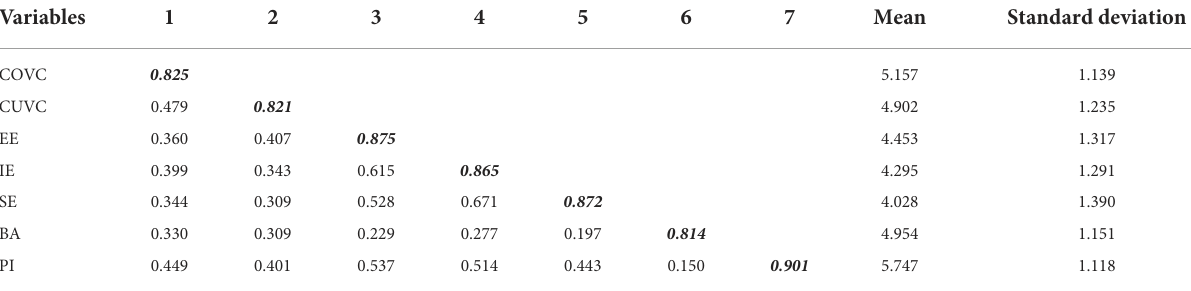
TABLE 3 Discriminant validity, means, and standard deviations.